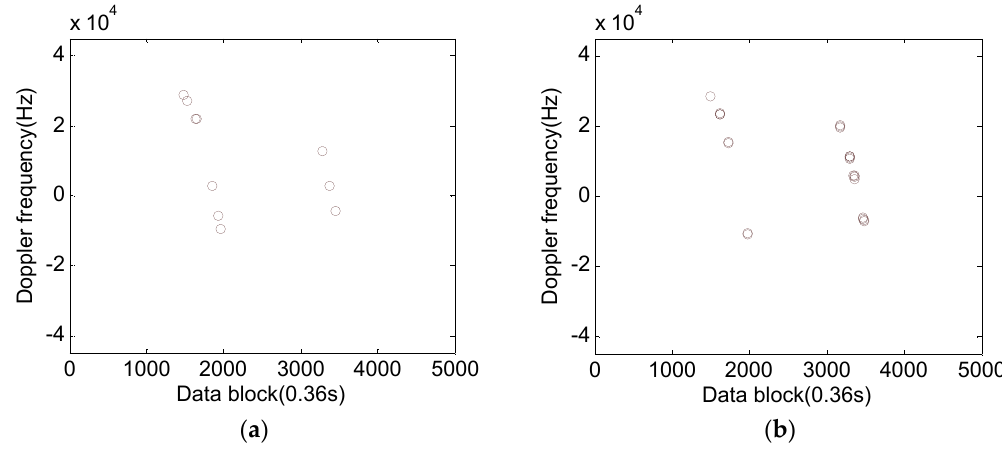
Figure 8. Doppler-shift estimation results of the IRIDIUM NEXT signals obtained by the traditional method: ( a ) Iridium ring alert signal Doppler-shift estimation results; ( b ) Iridium primary message signal Doppler-shift estimation results.